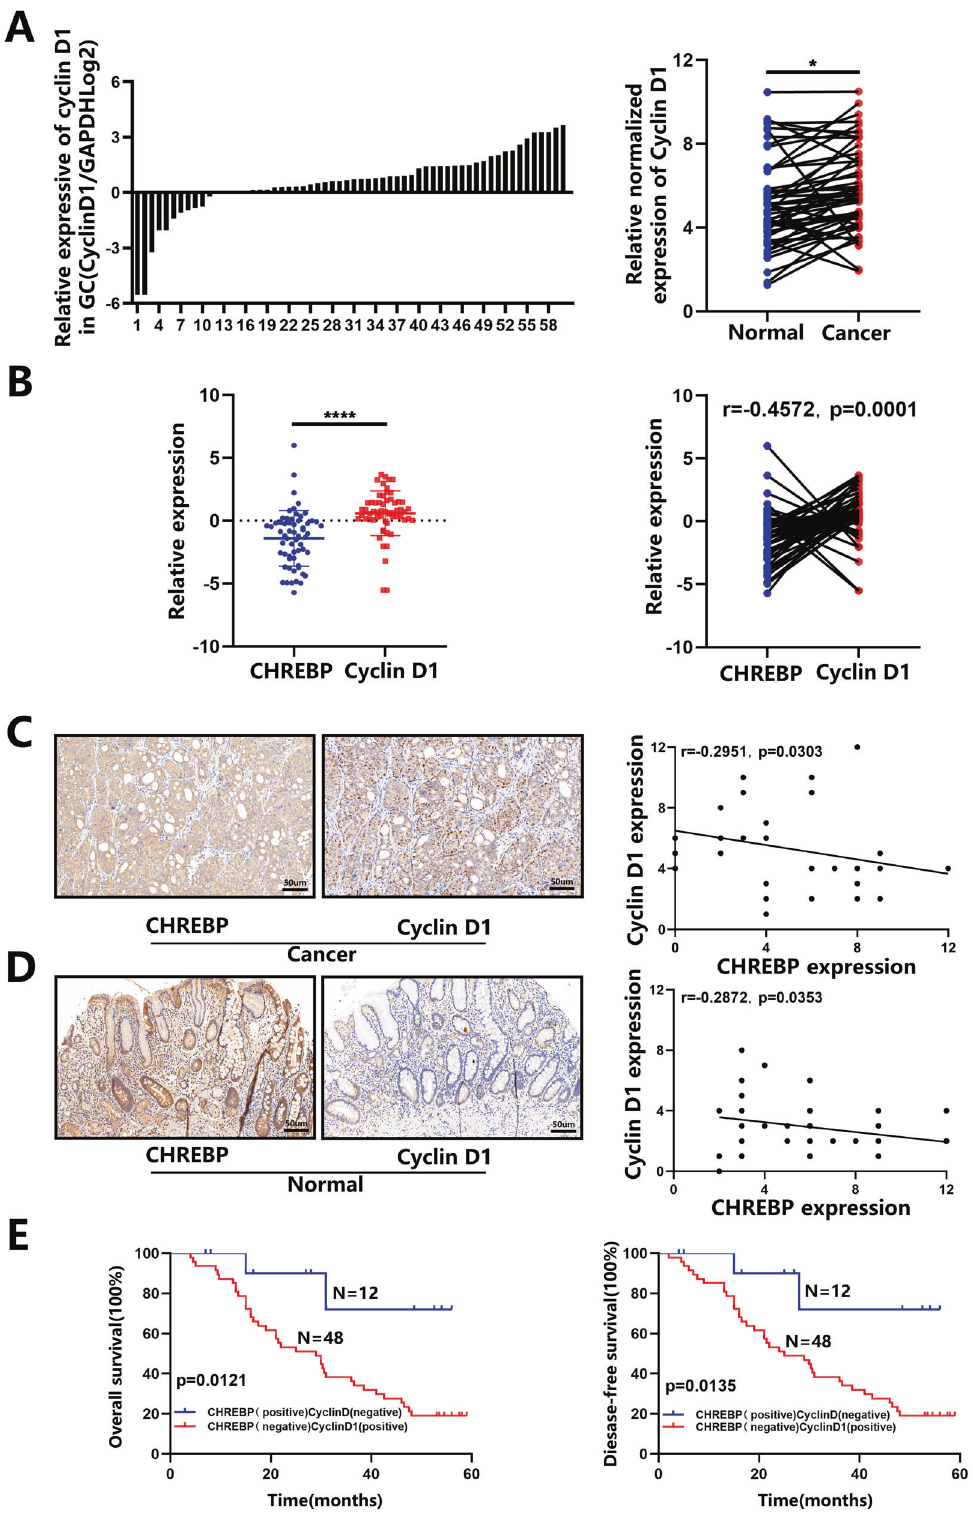
Fig. 6 The combination of CHREBP and cyclin D1 levels is useful for predicting GC prognosis. A Relative mRNA level of cyclin D1 in 60 GC in contrast with that in matched normal para-carcinoma samples. B A negative relationship between mRNA levels of CHREBP and cyclin D1 in 60 GC samples ( r = − 0.4572, P = 0.0001). C , D A negative relationship between the levels of CHREBP and cyclin D1 in GC tissues (scale bar: 50 μ m) ( C ; r = − 0.2951, P = 0.0303) and adjacent normal tissues ( D ; r = − 0.2872, P = 0.0353) was detected by IHC. E Prognostic values of CHREBP together with cyclin D1.